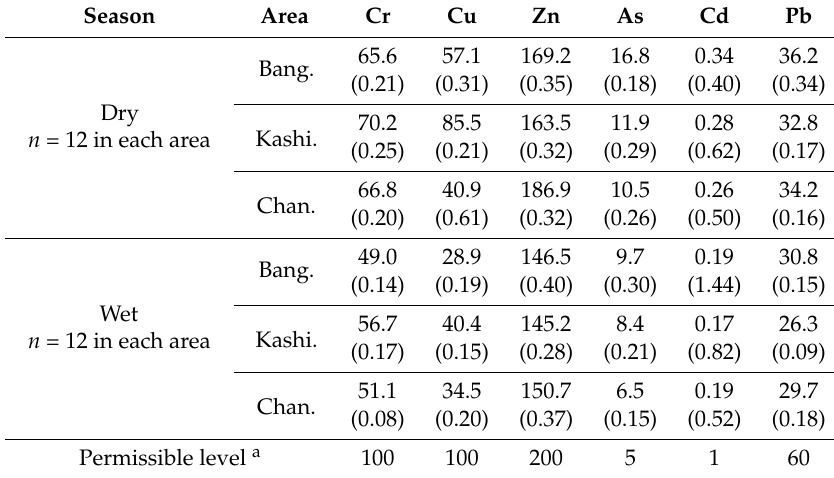
Table 2. Mean heavy metal concentration in soil (mg/kg) and coefficient of variation of concentration (in parentheses) in dry and wet seasons in the three areas.